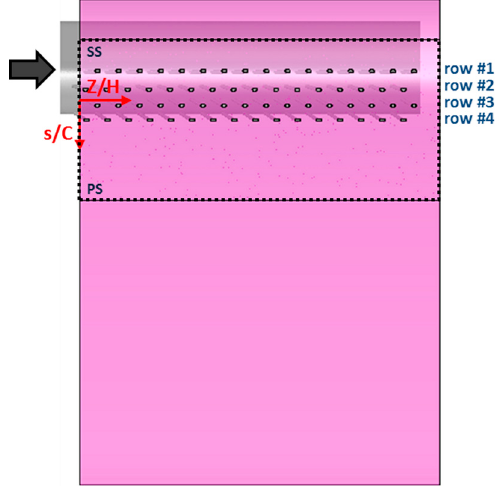
Figure 3. Showerhead geometry with plenum.